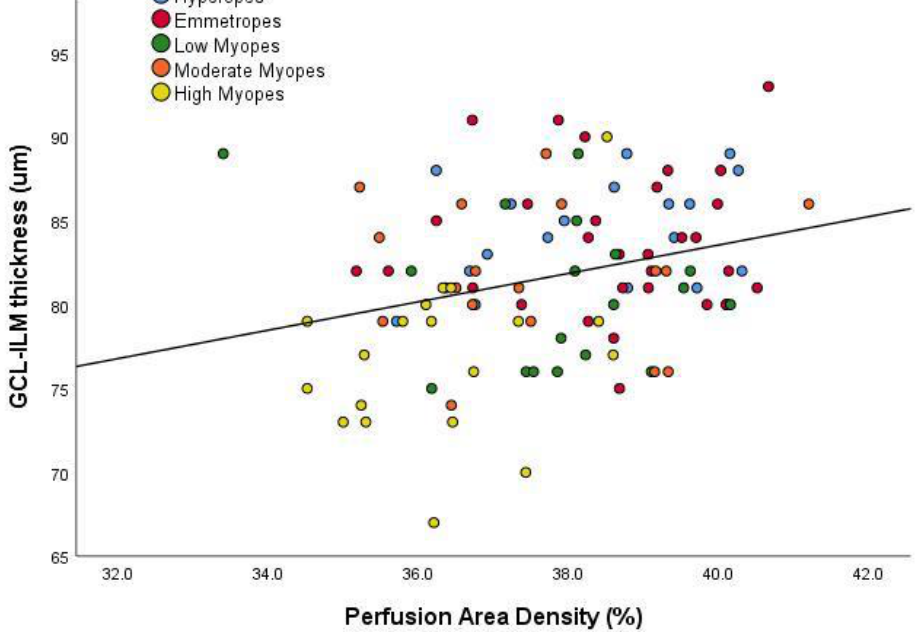
Figure 7. Scatter plot demonstrating the relationship between GCL-IPL Ganglion Cell Layer-Inner Plexiform Layer. The colours distinguish the subjects for their particular eye size bin. The regression line indicates a significant relationship (r 2 = 0.083, p = 0.003).